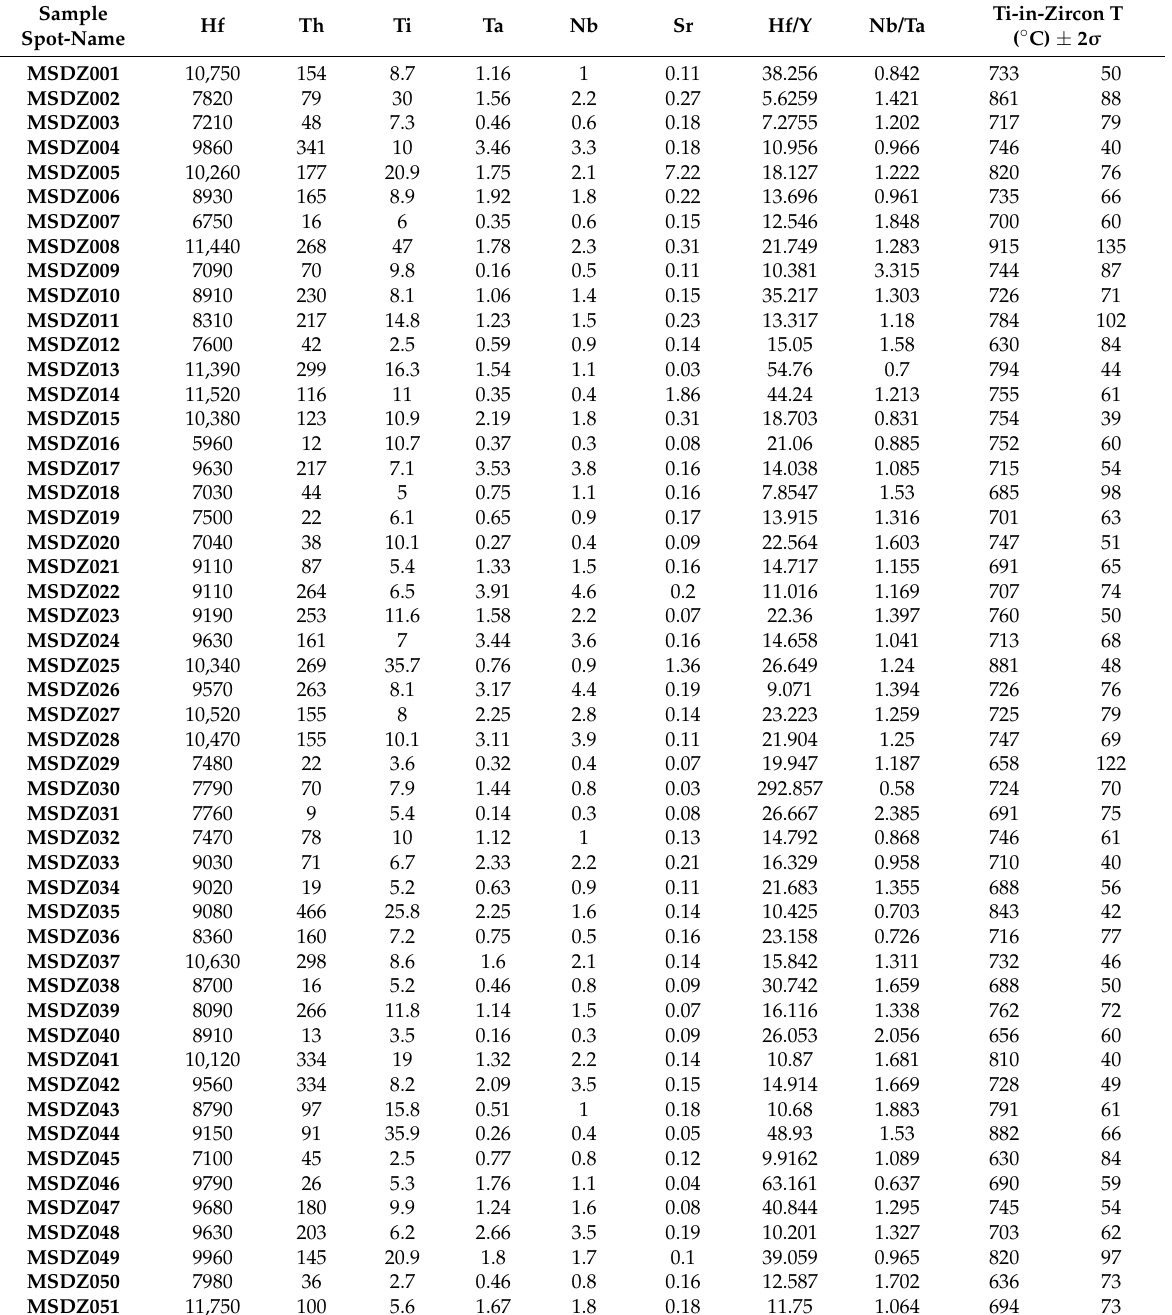
Table 2. Minor and trace element concentrations (ppm) in the southern Meiganga detrital